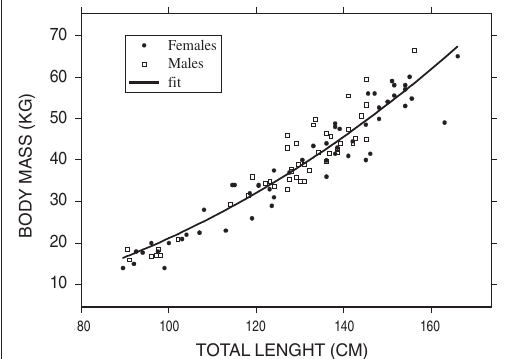
Fig. 9. Body weight (W) at length (L) for females and males combined, all areas, where W = 0.00058 L 2.281 . Standard error for the exponent is ± 0.092, standard error of constant is ± 0.00026, n